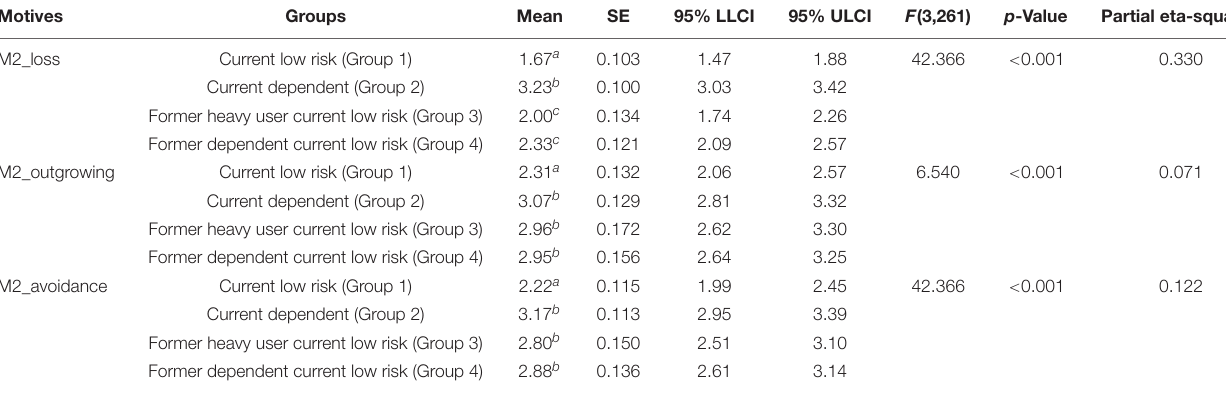
TABLE 7 | Multivariate ANOVA (MANOVA) for motives to decrease drinking across groups. Motives Groups Mean SE 95% LLCI 95% ULCI F (3,261) p -Value Partial